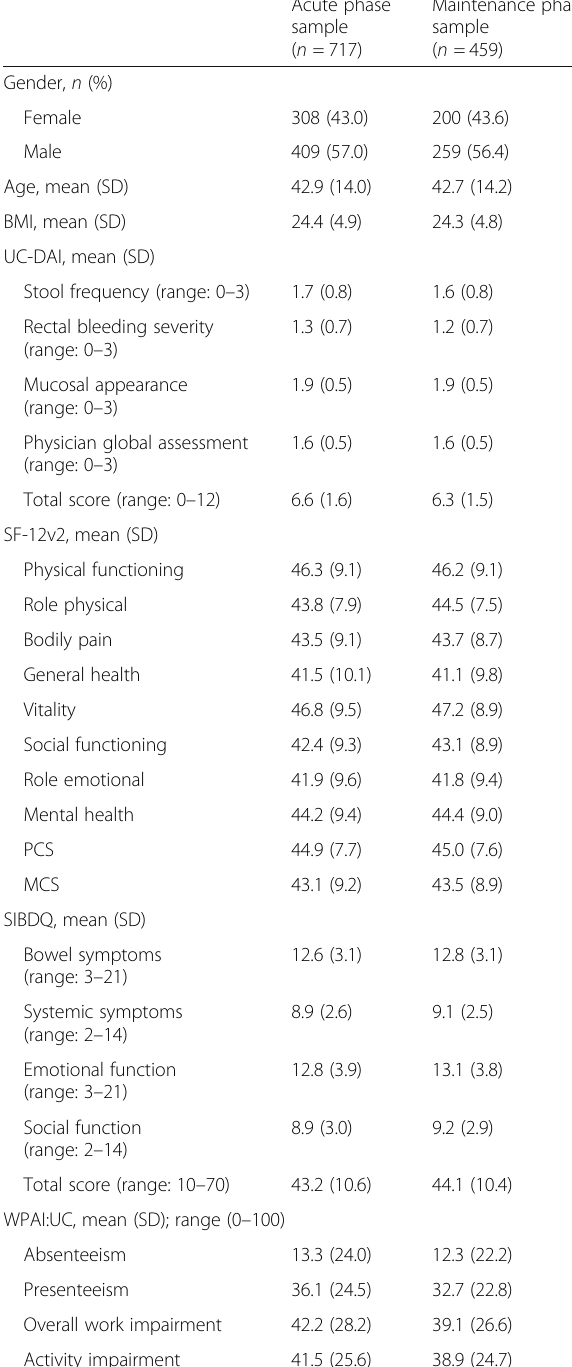
Table 1 Baseline characteristics for acute phase and maintenance phase